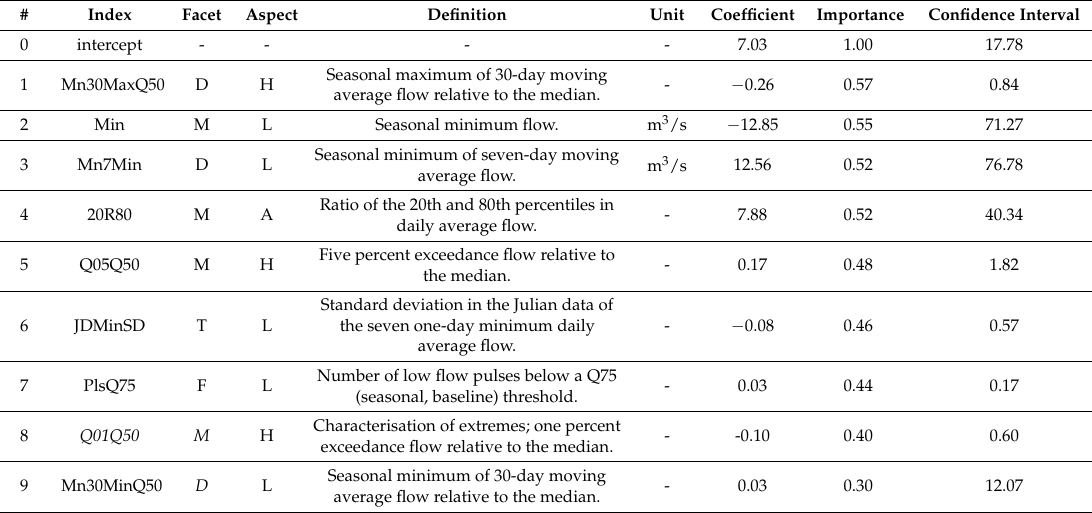
Table 4. Hydroecological model structure and index definitions ordered by relative importance. The facets of the flow regime are indicated by M (magnitude), D (duration), T (timing), and F (frequency), whilst the aspect of the flow regime is indicated by H (high), A (average), and L (low). The confidence interval is relative to the value of the